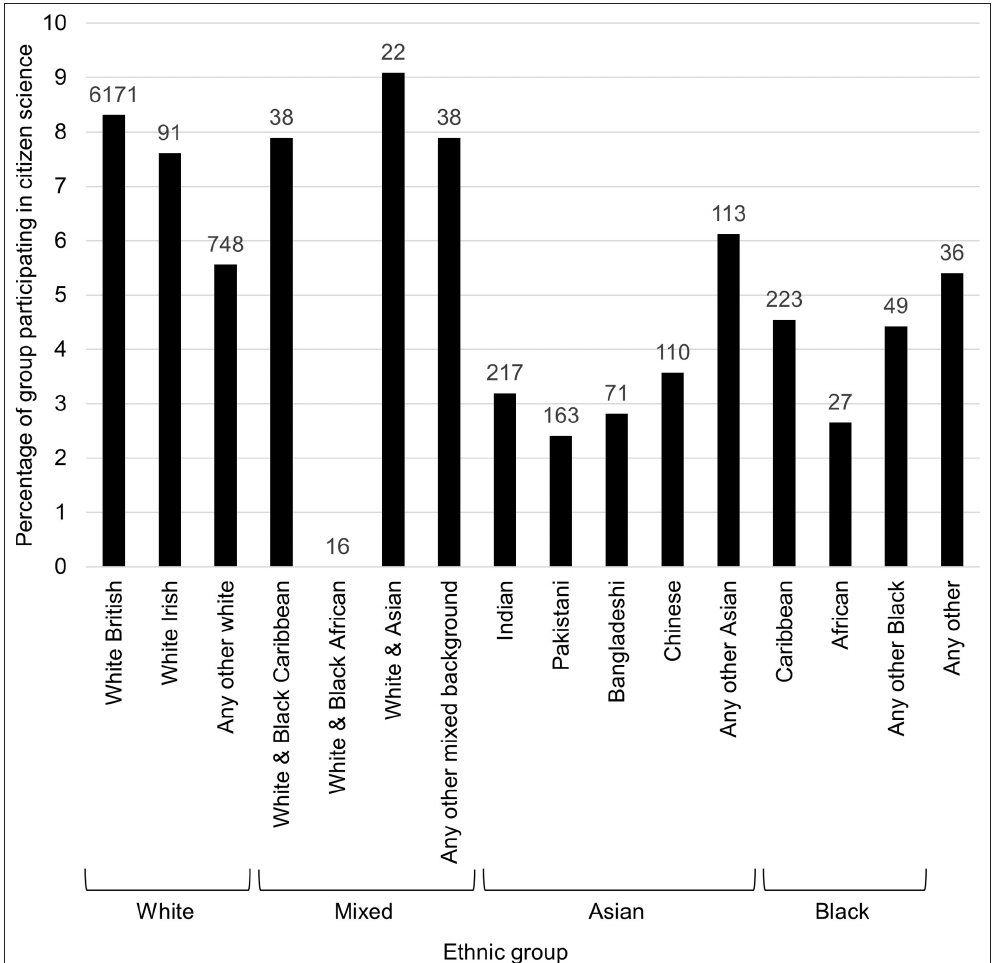
Figure 1 Percentage of interviewees identifying as being in each ethnic group who had participated in citizen science. Labels show the total number of respondents in each ethnic